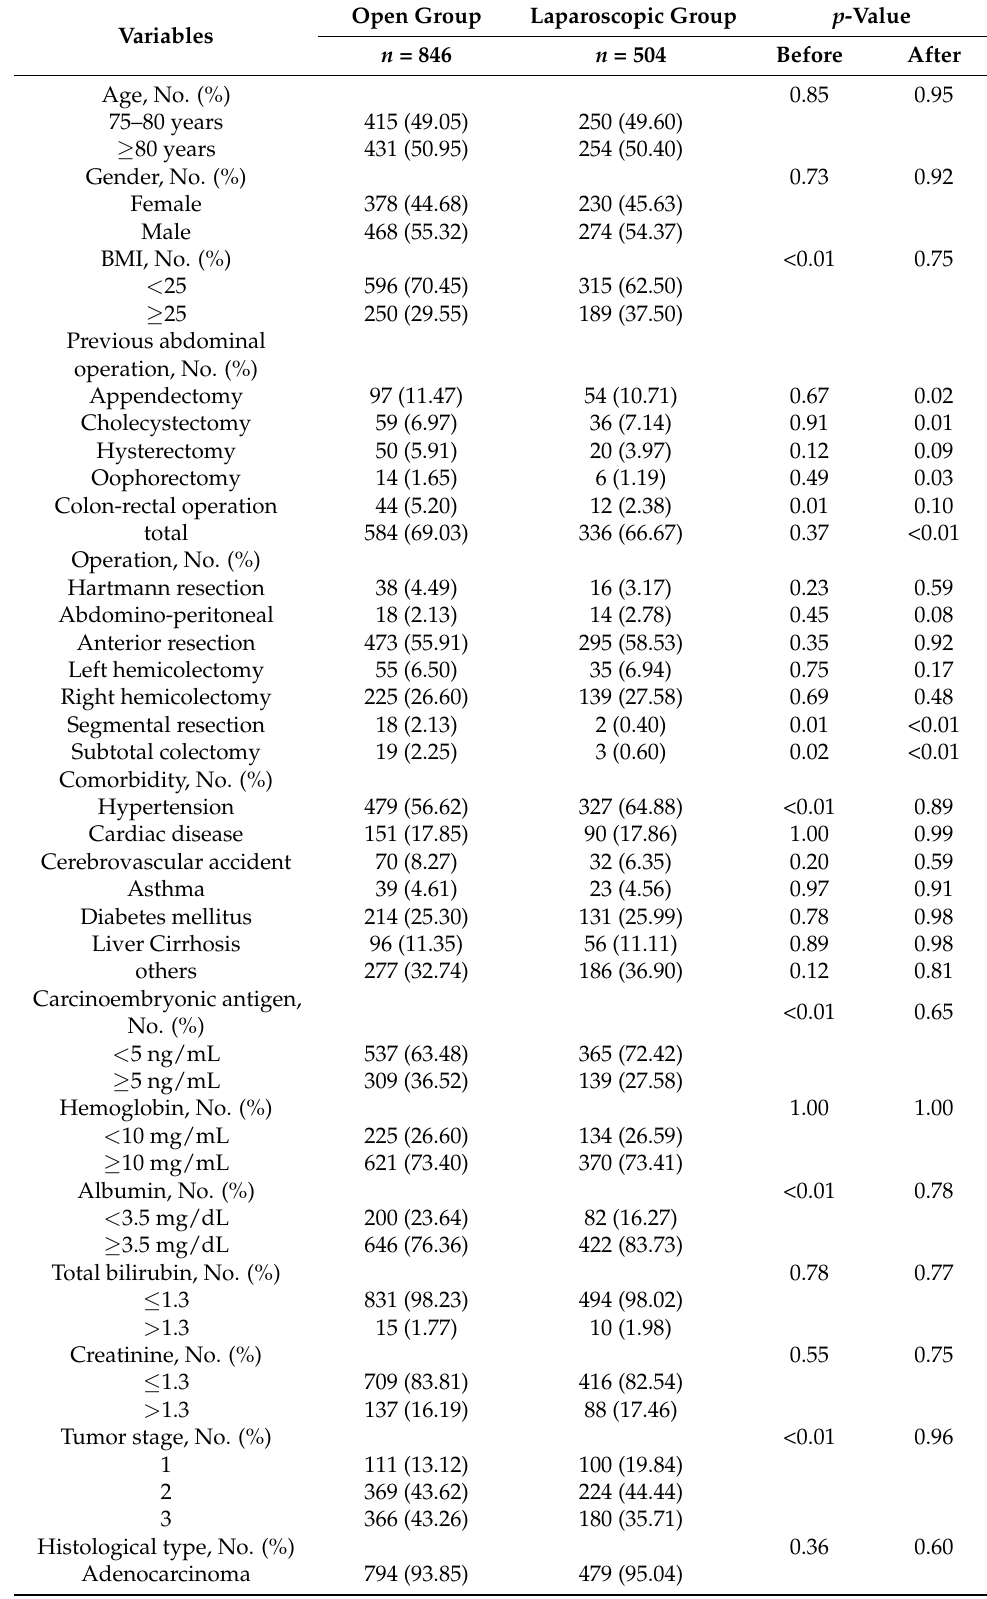
Table 1. Baseline characteristics of patients treated with open surgery vs. laparoscopy before and after propensity score